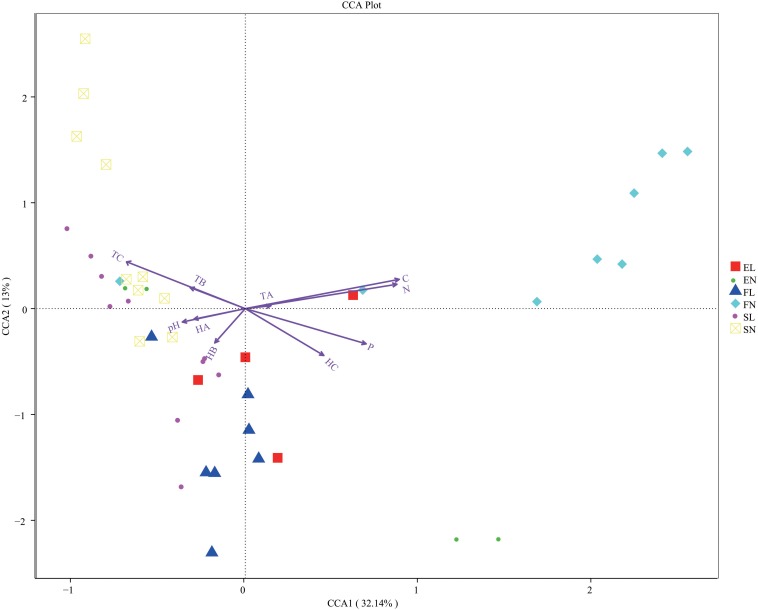
CCA analysis of three zones. The arrows represent different environmental factors, longer ray means greater the influence of the environmental factor. The angle between environmental factors represents the relationship between environmental factors and sample, acute means there is a positive correlation between the two environmental factors, while when it is obtuse, there is a negative correlation. CCA, canonical correspondence analysis; FL, black locust in forest habitat; FN, native plants in forest habitat; EL, black locust in forest-steppe habitat; EN, native plants in forest-steppe habitat; SL, black locust in steppe habitat; SN, native plants in steppe habitat. Results are mean of replicates ± standard deviation.